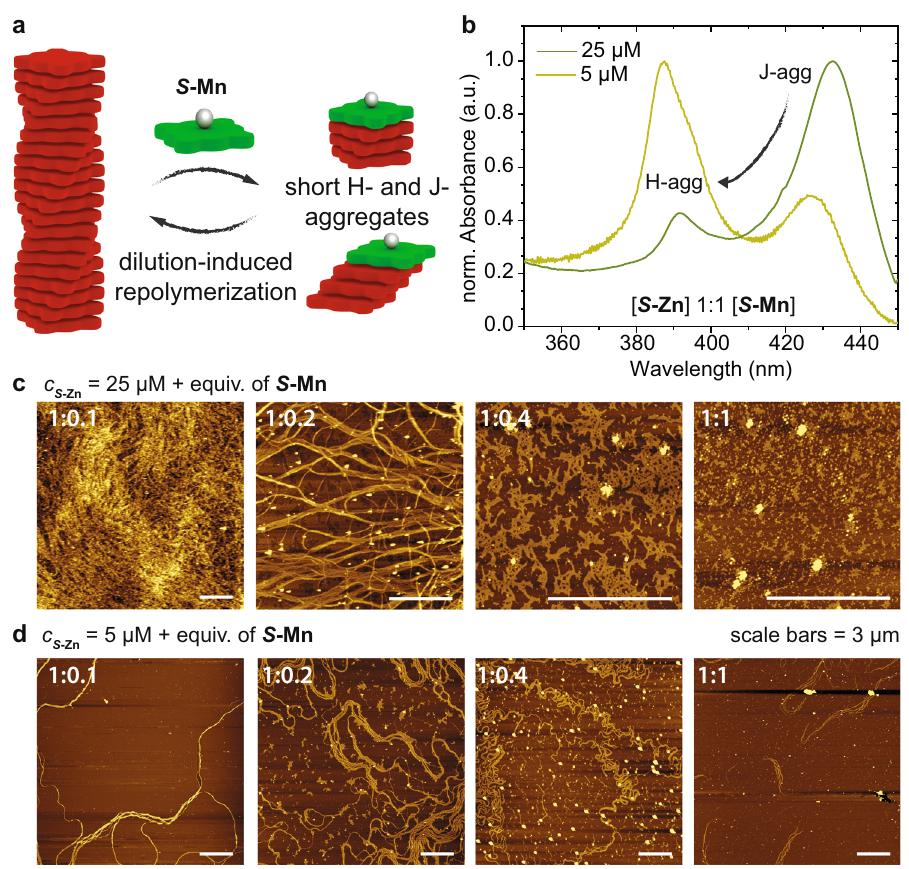
Fig. 6 Dilution-induced supramolecular polymerization of porphyrin-based polymers. a Schematic representation of dilution-induced supramolecular polymerization process. b Absorbance spectra showing the dilution-induced repolymerization from J- to H-aggregates when decreasing the concentration from 25 to 5 μ M for a 1:1 mixture of S -Zn/ S -Mn in MCH. c AFM images at c S -Zn = 25 µ M and ( d ) c S -Zn = 5 µ M showing the depolymerization with added equivalents of chain-capper at high concentration, and the reforming of supramolecular fi bers in dilute solutions. Samples were prepared by drop-casting the solutions on mica, scale bars represent 3 μ